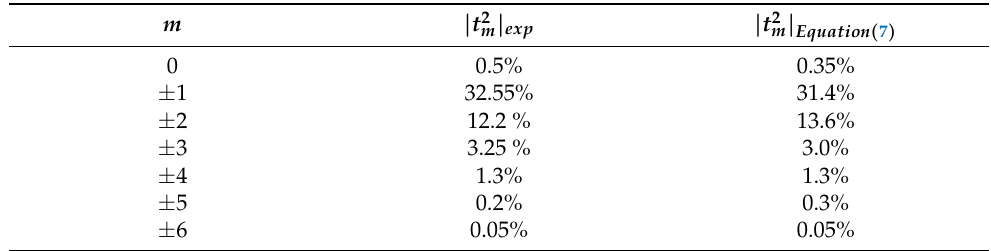
Table 1. Experimental and predicted diffraction efficiencies for λ 0 = 632.8 nm of the grating designed to suppress its zero